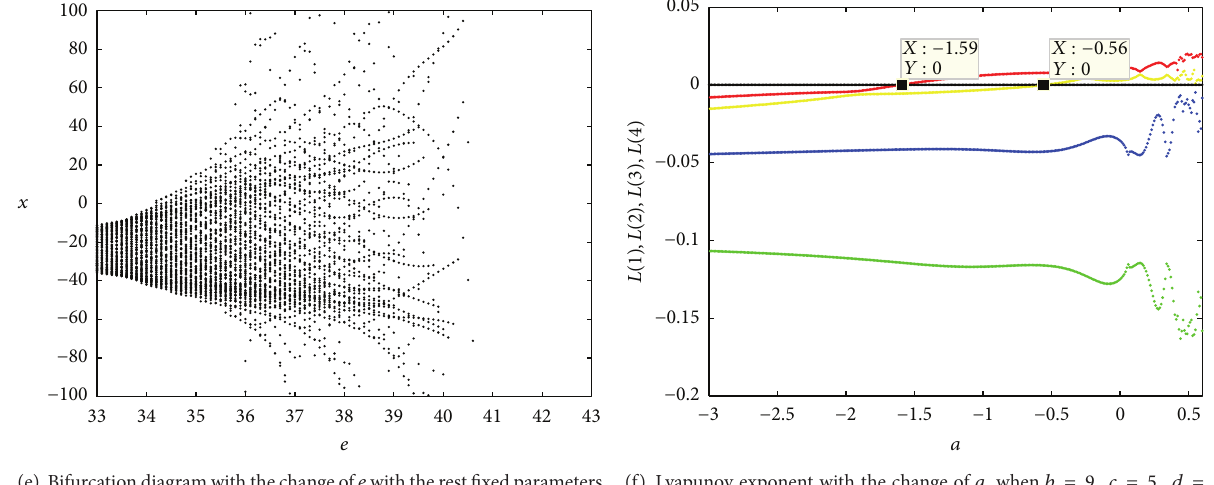
(e) Bifurcationdiagramwiththechangeof 𝑒 withtherestfixedparameters (f) Lyapunov exponent with the change of 𝑎 , when 𝑏 = 9, 𝑐 = 5, 𝑑 = 0.06, and 𝑒 = 25 Figure 7: Bifurcation diagram and the Lyapunov exponent when 𝑥 = 11.28 , 𝑦 = −11.21 , 𝑧 = −9 , and 𝑤 = 20.49 and the step length is